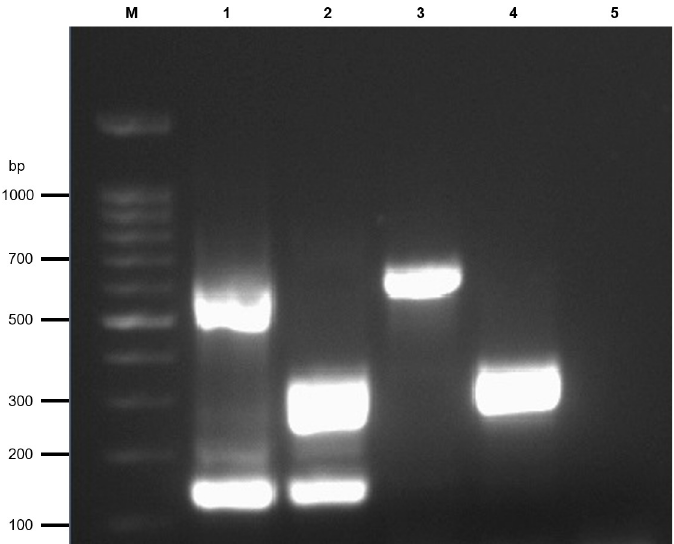
Fig 1. Multiplex RT-PCR. Agarose gel electrophoresis of PCR products amplified from RNA extracted from NNV reference strains. Lane M: 100 bp ladder (Invitrogen, Carlsbad, USA); Lane 1: RGNNV genotype; Lane 2: RGNNV/ SJNNV reassortant strain; Lane 3: SJNNV/RGNNV reassortant strain; Lane 4: SJNNV genotype; Lane 5: No template control; Molecular weight markers (bp) are indicated to the left of the gel.